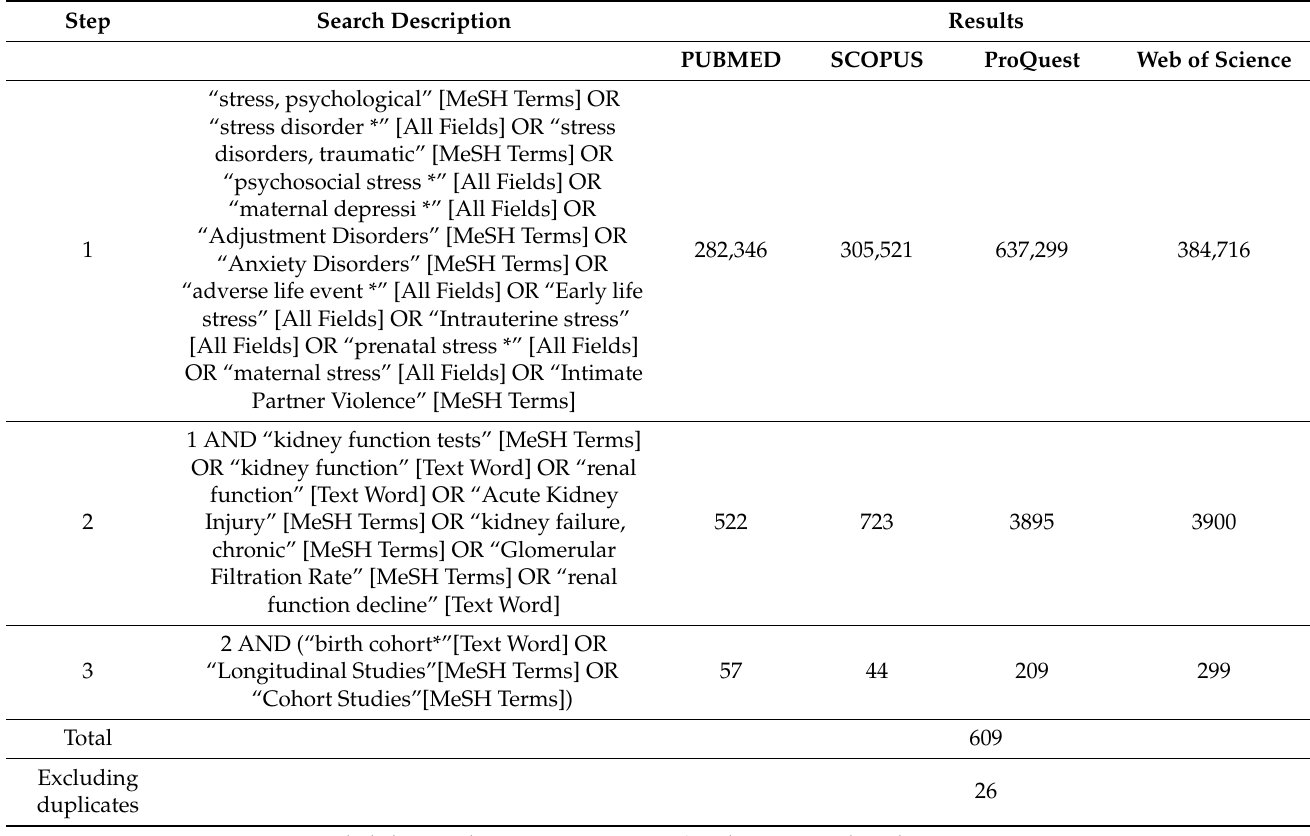
Table 1. Search strategy, terms, and results for traditional